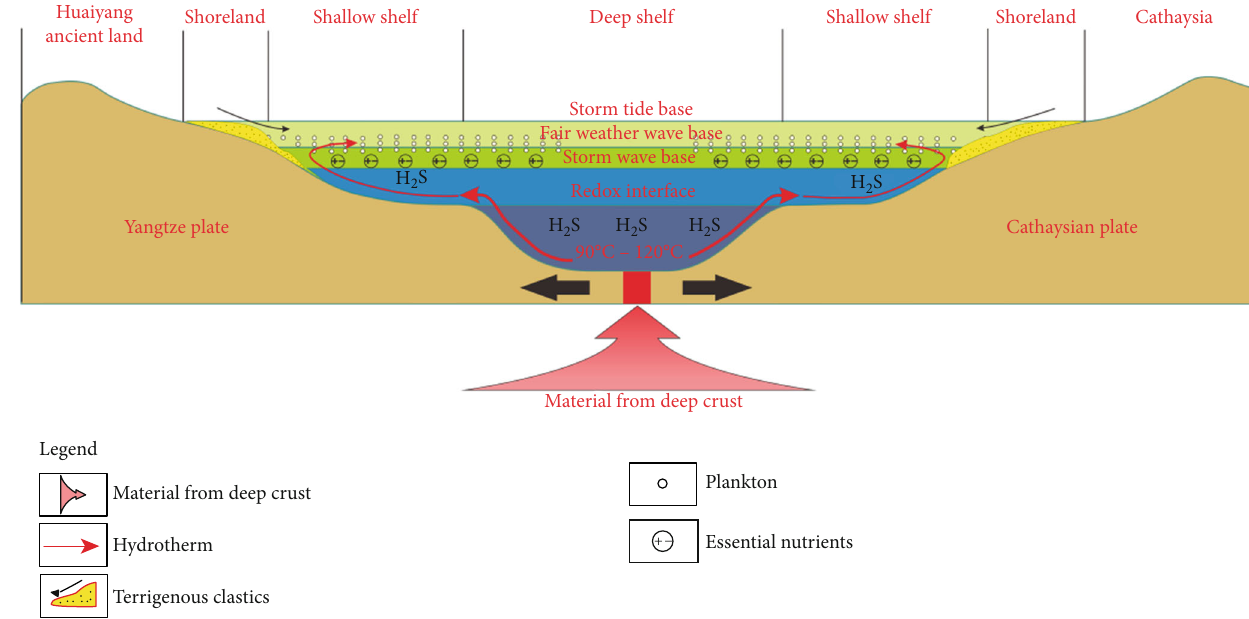
Figure 7: Mechanism of organic matter enrichment in the early Cambrian Wangyinpu Formation in the Lower Yangtze